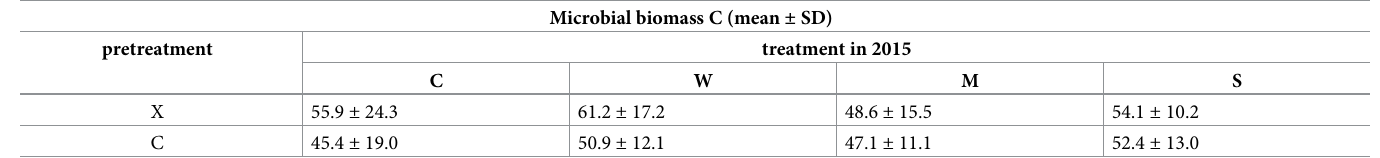
Table 4. Microbial